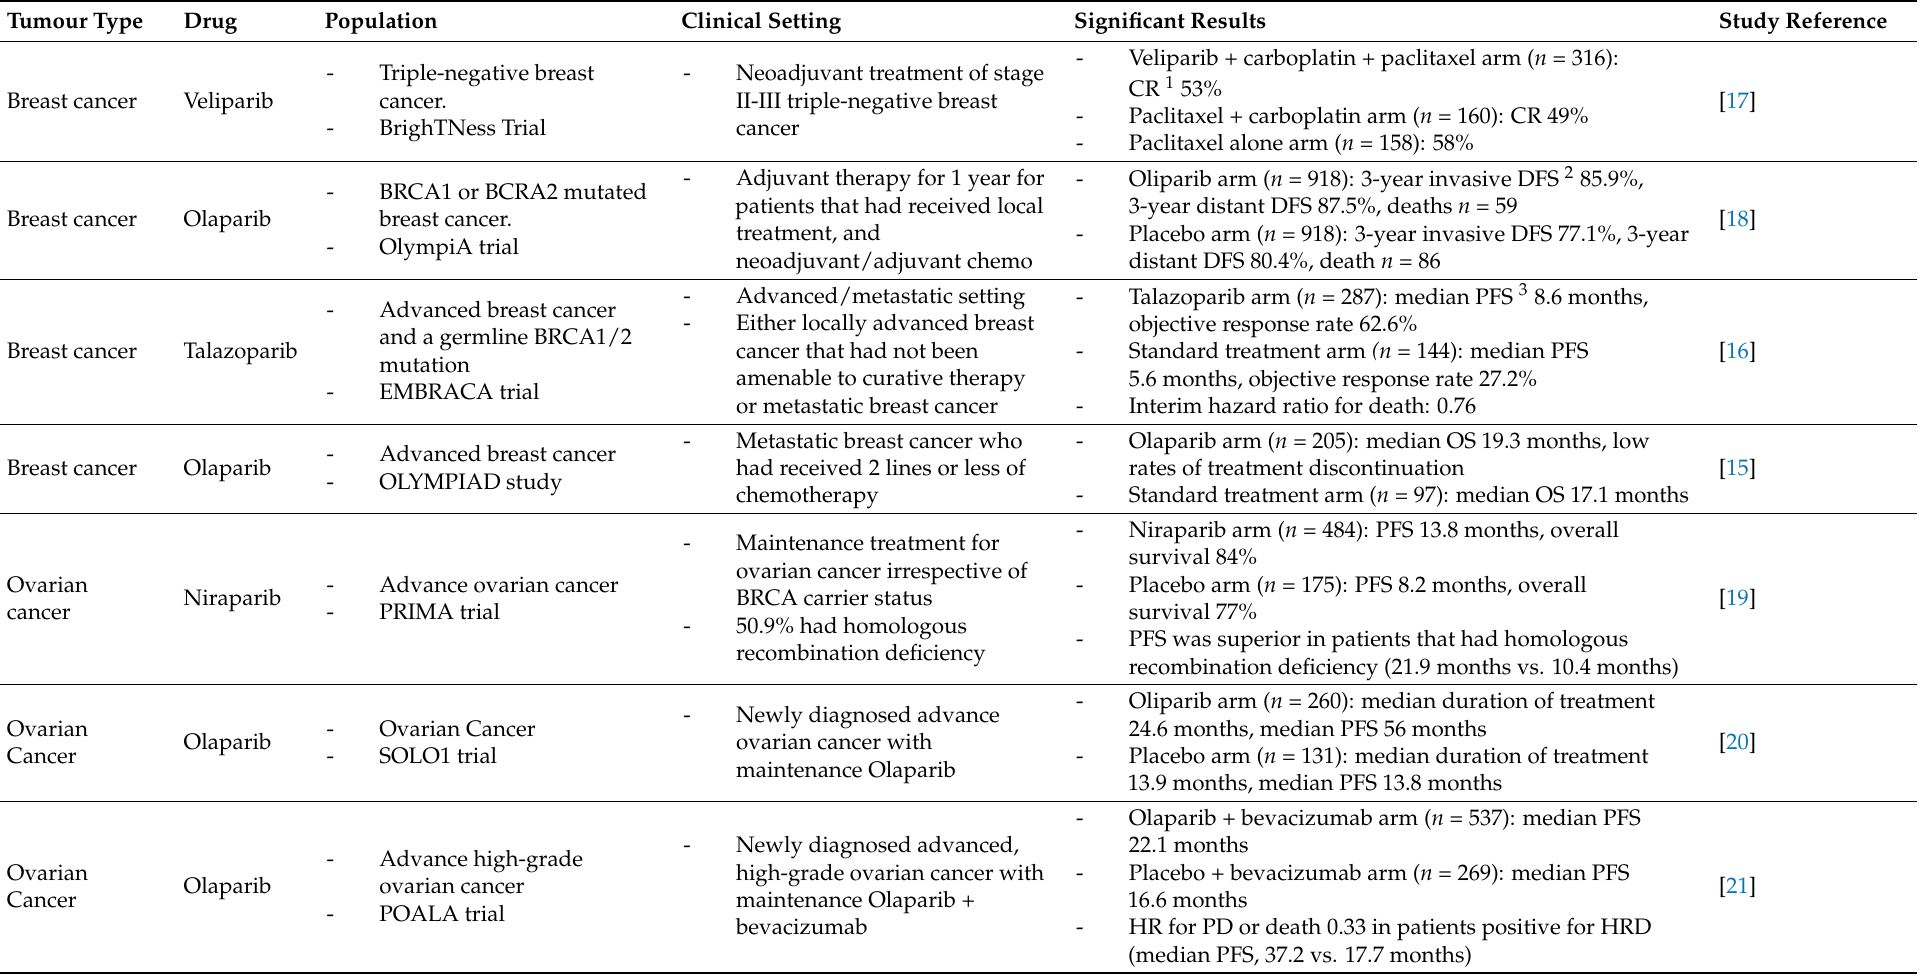
Table 1. Key trials demonstrating use of PARPI inhibitors in cancer